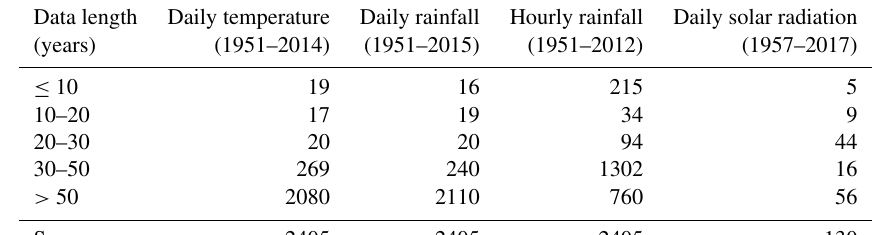
Table 2. Data lengths for daily temperature, daily and hourly precipitation, and daily solar radiation for stations used in this study.